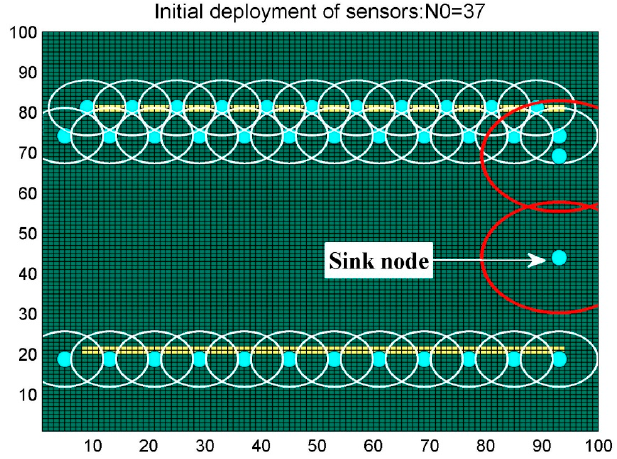
Figure 16. Initial sensor deployment “Scenario 2”.